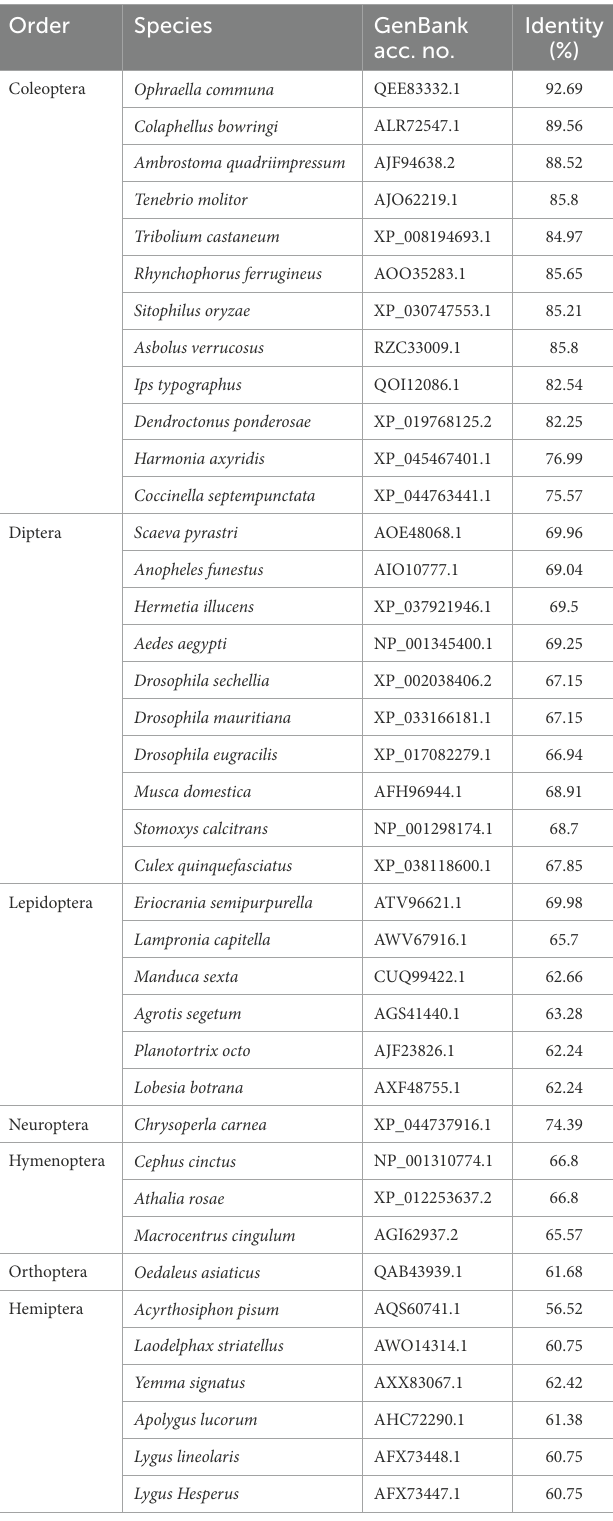
TABLE 2 Percent identities between AhygOrco and Orco orthologs in other insect species. Order Species GenBank